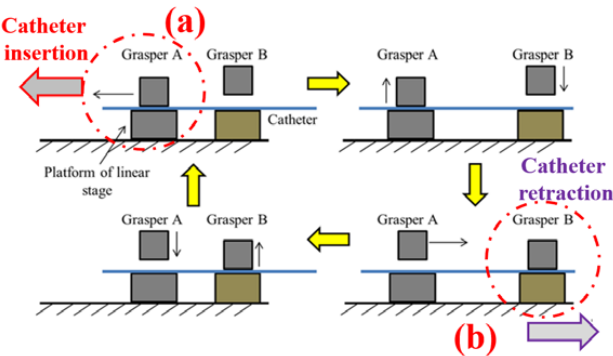
Figure 13. Schematic diagram of catheter insertion. ( a ) Catheter insertion, ( b ) Catheter retraction .